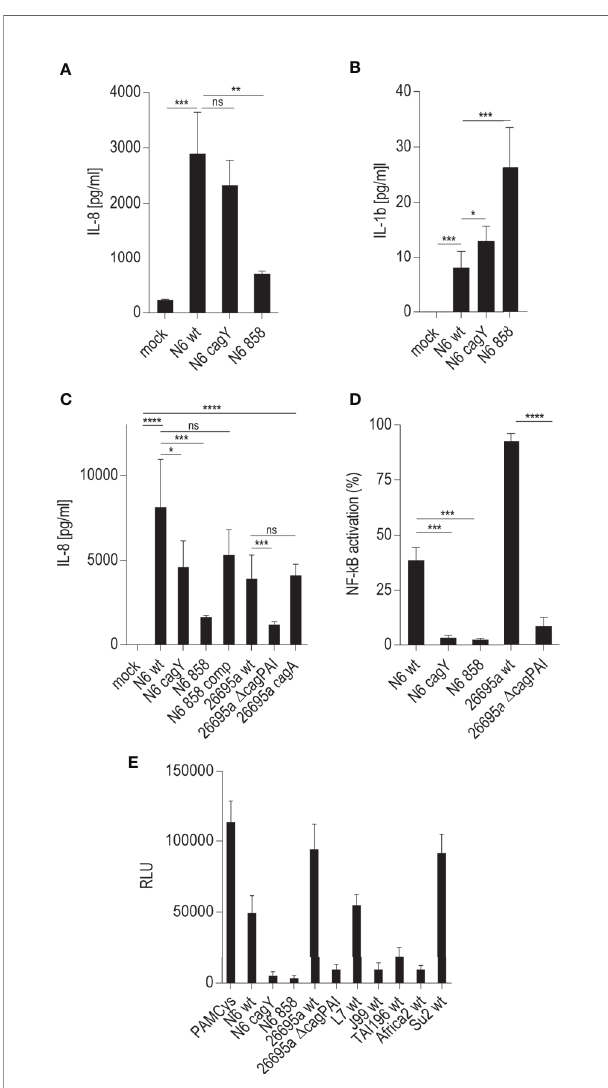
FIGURE 1 | Signi fi cant role of LPS inner core heptose biosynthesis and the cag PAI in co-incubated Thp-1 cells activated by H. pylori or its isogenic mutants. In (A) , the IL-8 secretion by Thp-1 cells co-cultured with strain N6 wild type (N6 wt) and isogenic cagY and hldE (HP0858 – 858) mutants as a marker for cell activation is shown (20 h co-incubation, MOI = 5, no pre-activation). (B) low IL-1 b secretion in Thp-1 cells co-incubated with the same set of strains at MOI = 10, 20 h (no IL-1 b was detected at MOI 5). (C) comparison of IL-8 secretion in Thp-1 cells co-incubated with two different H. pylori strains (N6 and 26695a) and their isogenic mutants (MOI = 25, 21 h). (D) Isolated quantitation of NF- k B activation using Thp1_luc cells, containing fi re fl y luciferase gene under the control of a high-af fi nity NF- k B promoter (Methods). Thp1_luc cells were co- incubated for 4 h with N6 and 26695a strains and their respective mutants (MOI = 10) as indicated. The values are shown as relative luminescence values, normalized to the activation by heptose-independent, reference substance PAMCys (TLR2 agonist; 20 ng/50 µl), which was set to 100%. (E) Quantitation of Thp1_luc NF- k B activation by various H. pylori strains (MOI = 10) shown as arbitrary luminescence units (RLU). Comparative values of activation by the PAMCys reference are indicated. One representative independent biological experiment out of three is depicted in each panel. Statistical signi fi cance of differences was calculated using unpaired student ’ s t -test. Signi fi cant p values: ****p < 0.0001; ***p < 0.001; **p < 0.01; *p < 0.05; ns is non signi fi